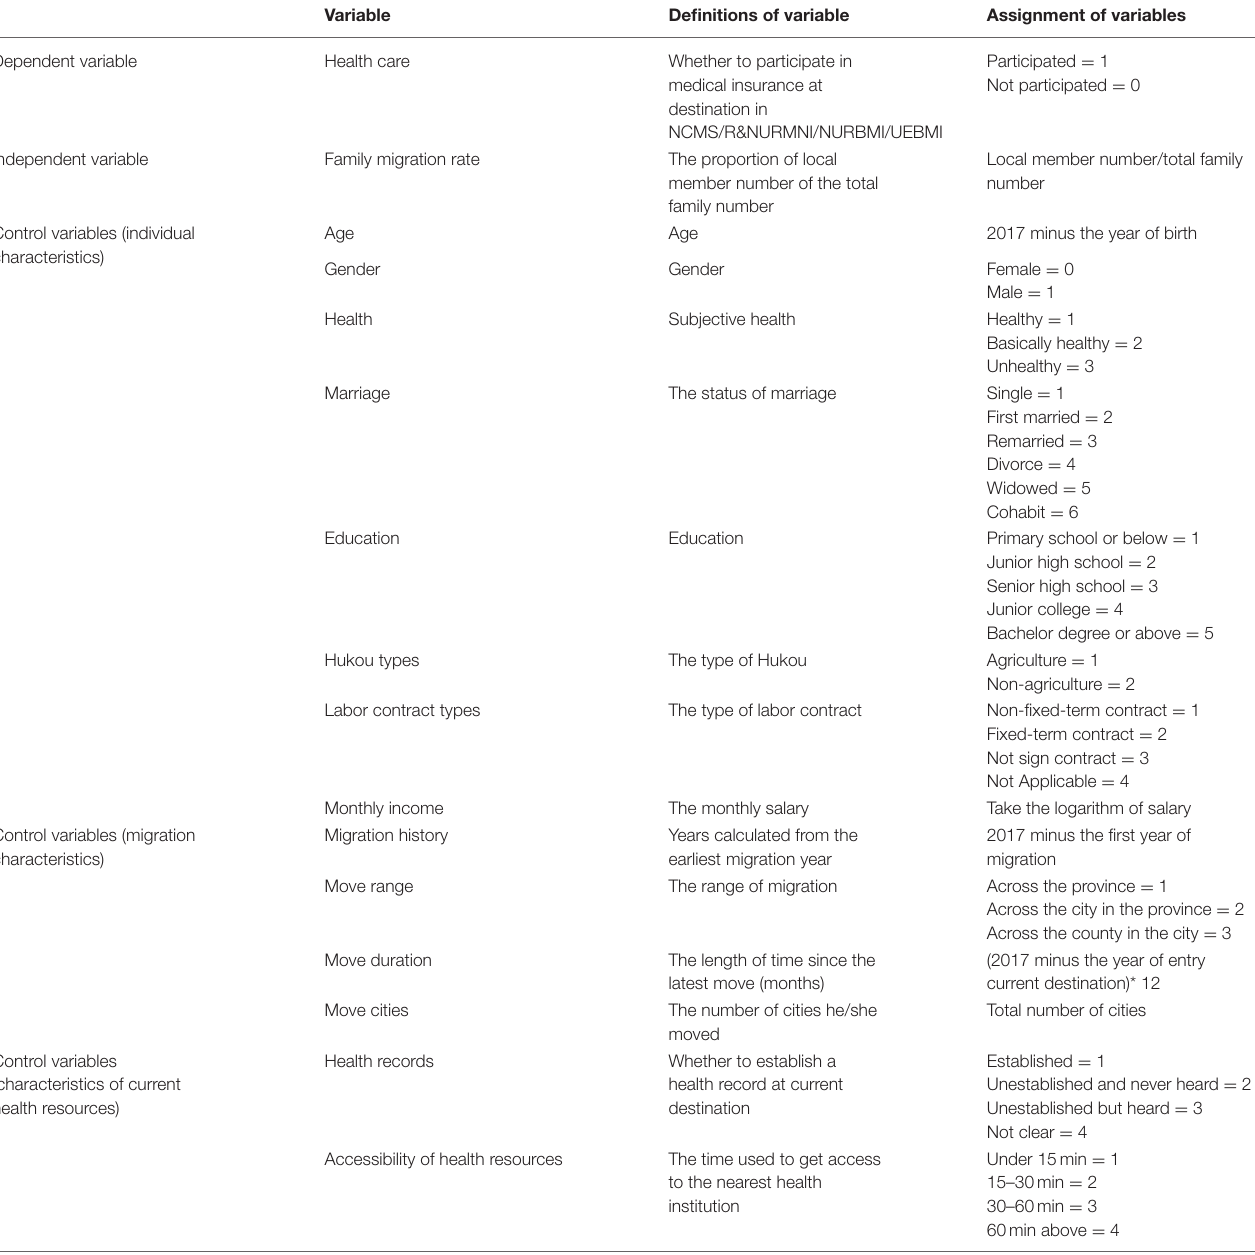
TABLE 1 | Definitions and assignment of variables ( N =